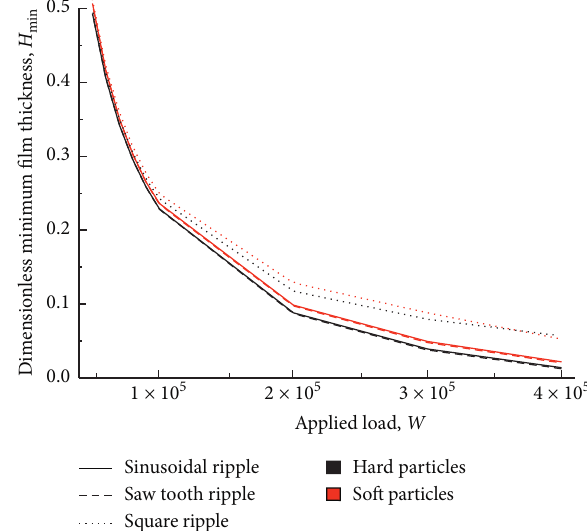
Figure 12: Effects of particle spacing on the traction